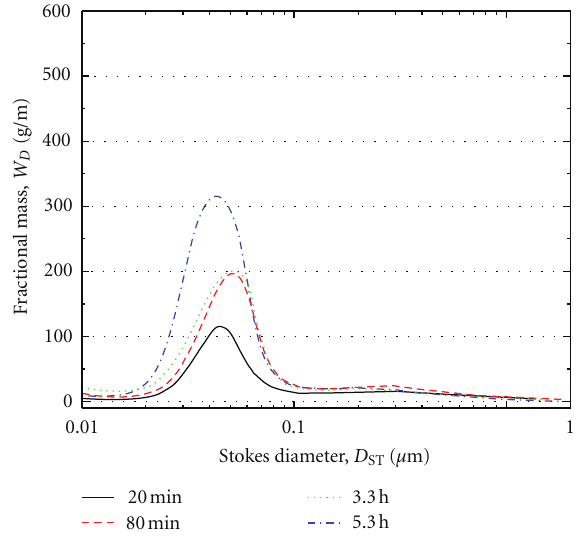
Figure 3: Particle size distributions of Arkema CNTs with increas- ing sonication time using a horn sonicator with flow cell at 20%